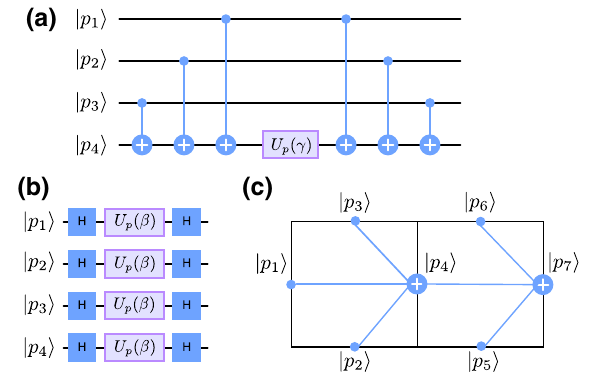
FIG. 3. (a) Circuit implementation of the operator e − i γ (cid:2) H B act- ing on a single plaquette, with a target and three control qubits. The states | p i (cid:3) are expressed in the ˆ σ z eigenbasis and U p (γ ) = e i γ ˆ σ z is a single-qubit rotation around the z axis. (b) Implemen- tation of the single-qubit operations that describe e − i β (cid:2) H E . (c) Example of the sequential implementation of the operator e − i γ (cid:2) H B on two neighboring plaquettes. The qubit | p 4 (cid:3) is used first as the target qubit for the first plaquette and afterwards as a control qubit for the second.